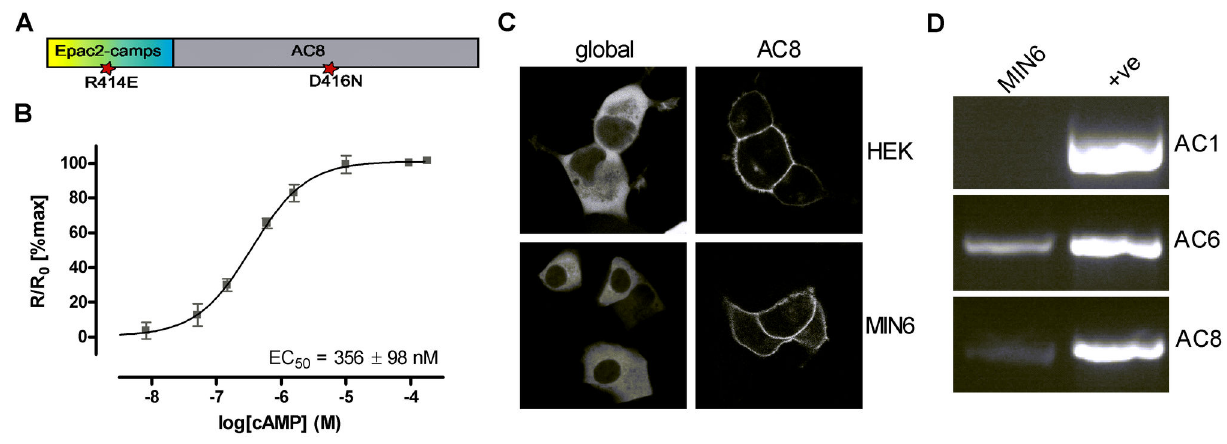
Figure 2. Development of an AC8-targeted sensor for use in MIN6. ( A ) Cartoon showing the Citrine/Cerulean sensor fused to the N-terminus of AC8 with inactivating mutations in Epac2-camps and AC8 indicated. ( B ) The cAMP sensitivity of the targeted sensor was determined in vitro by addition of increasing concentrations of cAMP to crude membranes prepared from HEK293 cells expressing the sensor. EC presented as mean±SD (n=4). ( C ) Confocal images of HEK293 and MIN6 cells expressing the global 50 and AC8 targeted forms of the Ci/Ce sensor. ( D ) RT-PCR to identify Ca 2+ -regulated adenylyl cyclases in MIN6 cDNA and in positive control